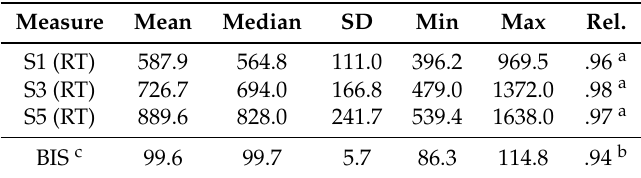
Table 1. Descriptives for the Sternberg Task and the BIS.